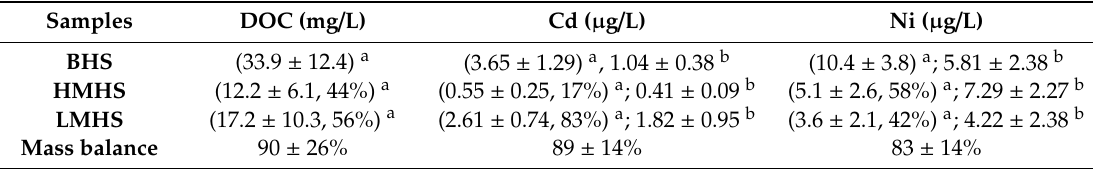
Table 3. Cadmium (Cd) and Nickel (Ni) and C content in BHS, HMHS, and LMHS solutions ( n =